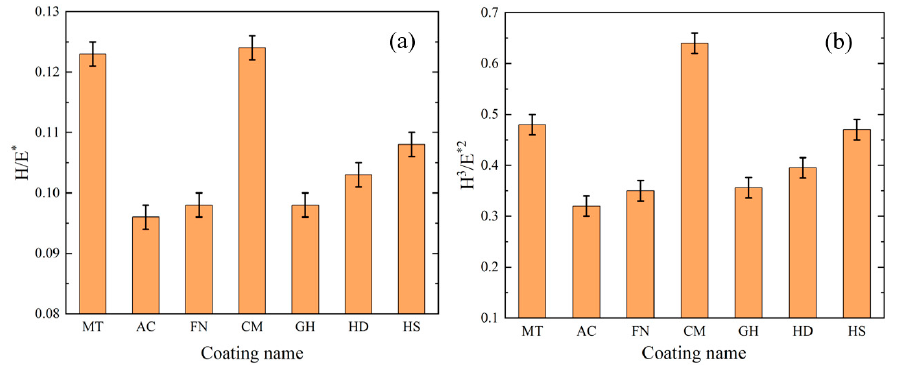
Figure 10. H/E* and H 3 /E* 2 values of different coatings.